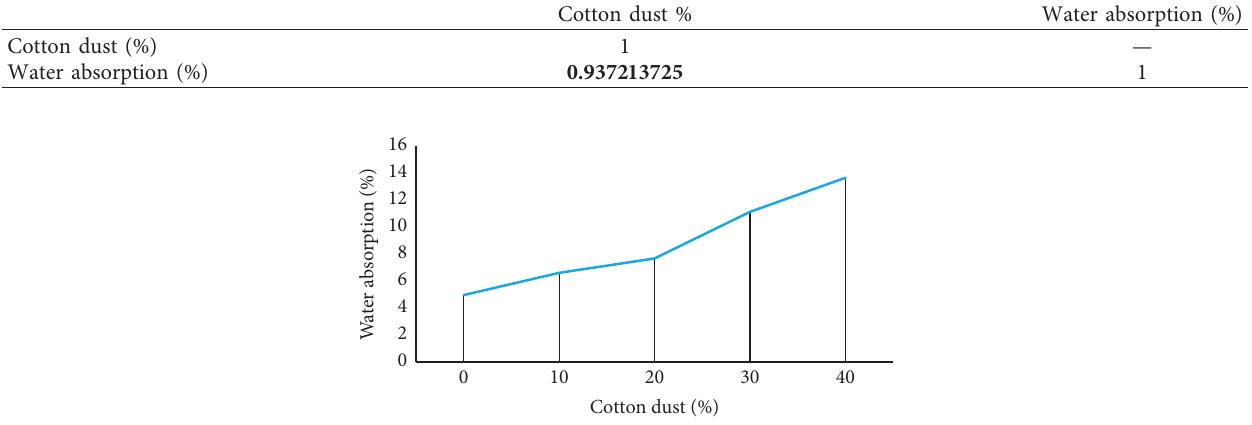
Table 7: Correlation analysis for water absorption of brick samples.